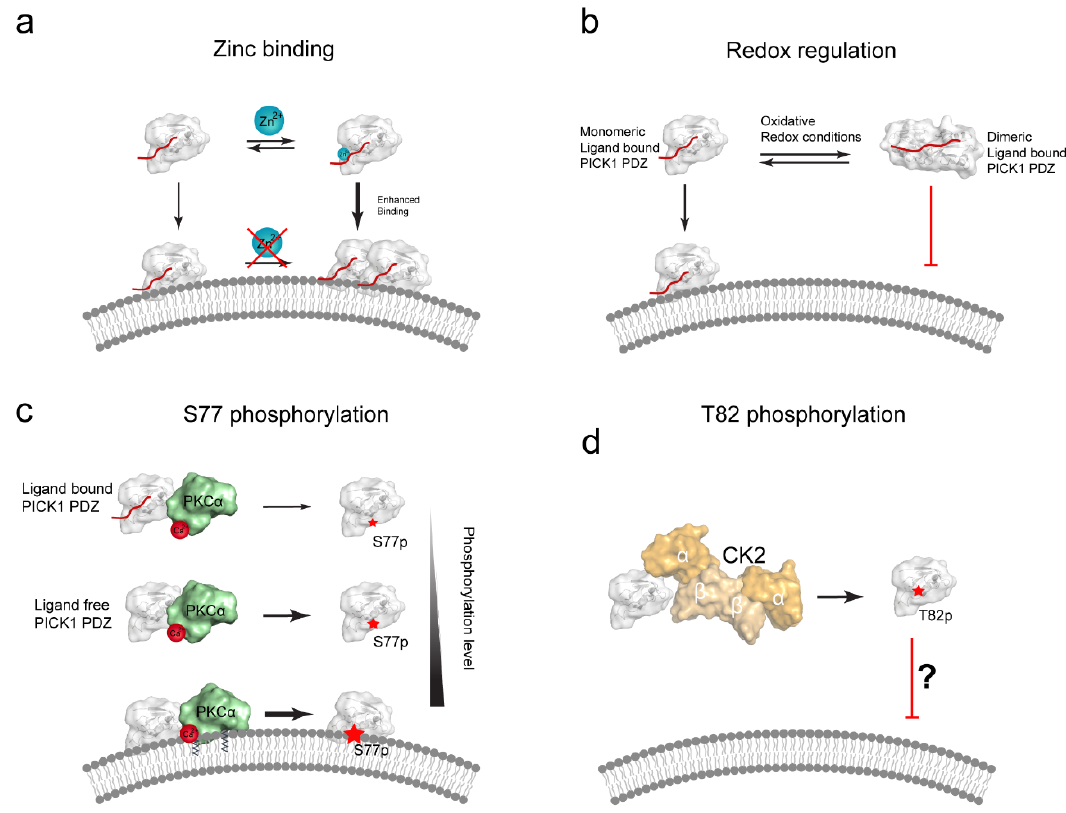
Figure 4. Proposed regulatory mechanisms for the PICK1 PDZ membrane